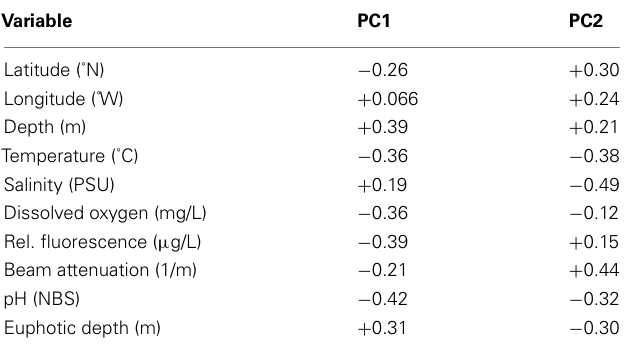
TableA5 |Variables contributing to principal components axes.